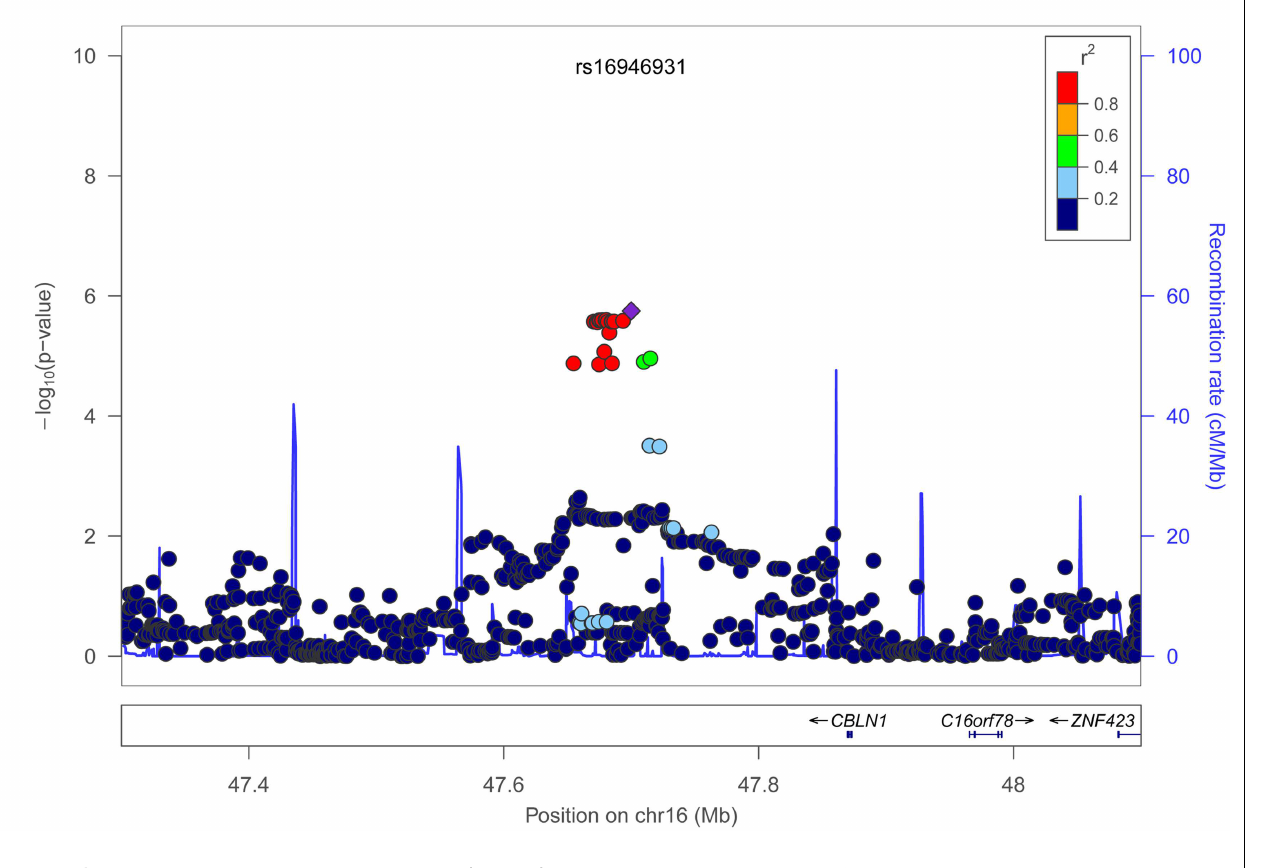
FIGURE 5 | Regional association plot of SNP rs16946931 ( ± 400kb) . Statistical significance of each SNP on the –log10 scale as a function of the chromosome position.The top SNP is shown as the purple